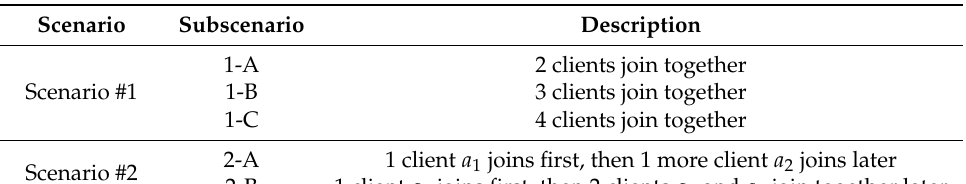
Table 4. Experimental